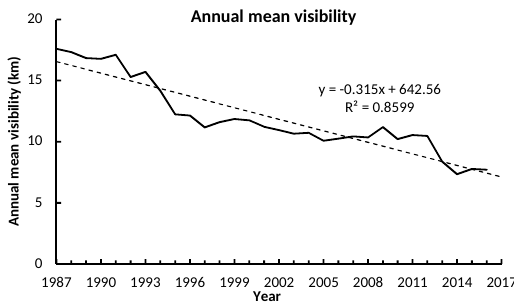
Figure 3. Variation of annual mean visibility (km) of Xiamen, China, during 1987–2016. In the formula, y represents the value of AV (km), and x refers to the time (year).